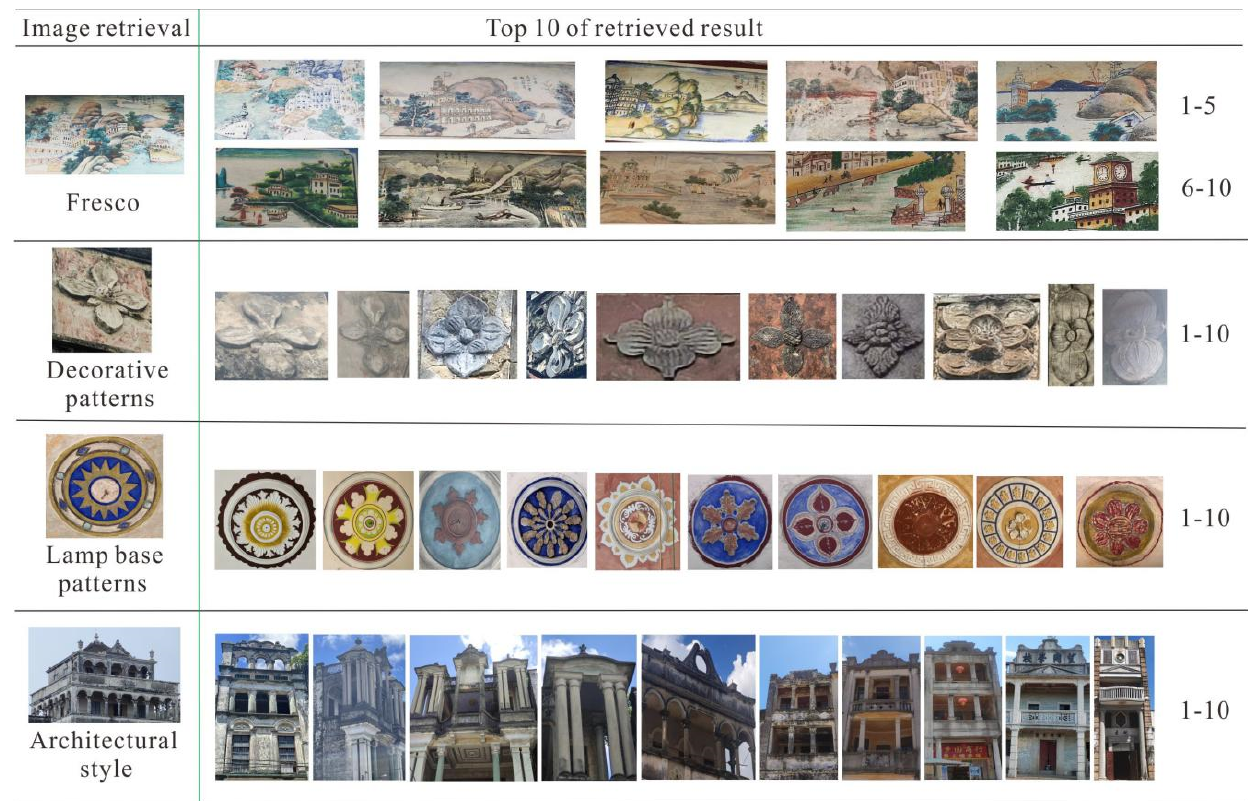
Figure 14. Image retrieval results of top 10 architectural heritage.